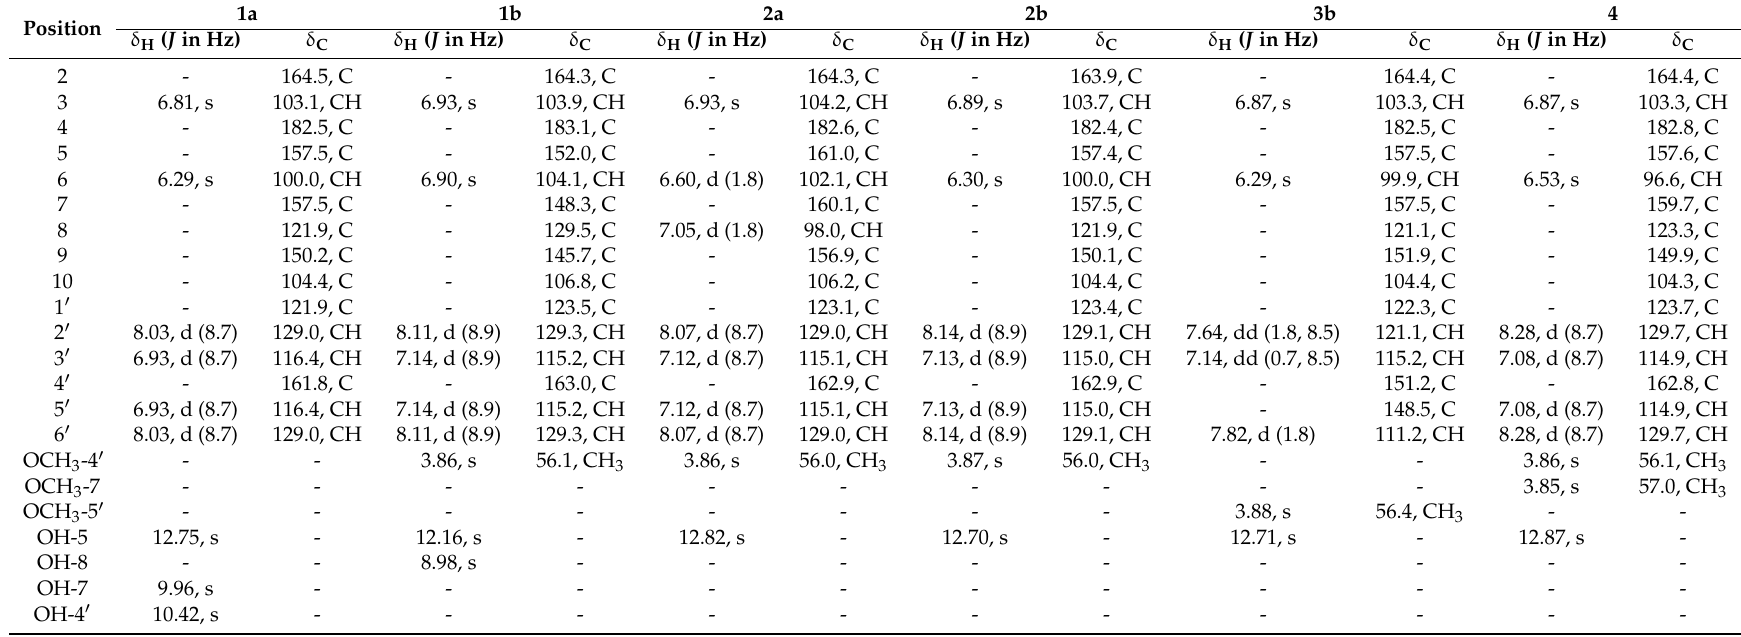
Table 1. NMR data (DMSO- d 6 , 1 H 400 MHz and 13 C 100 MHz) of O -sulphated flavonoids from Wissadula periplocifolia